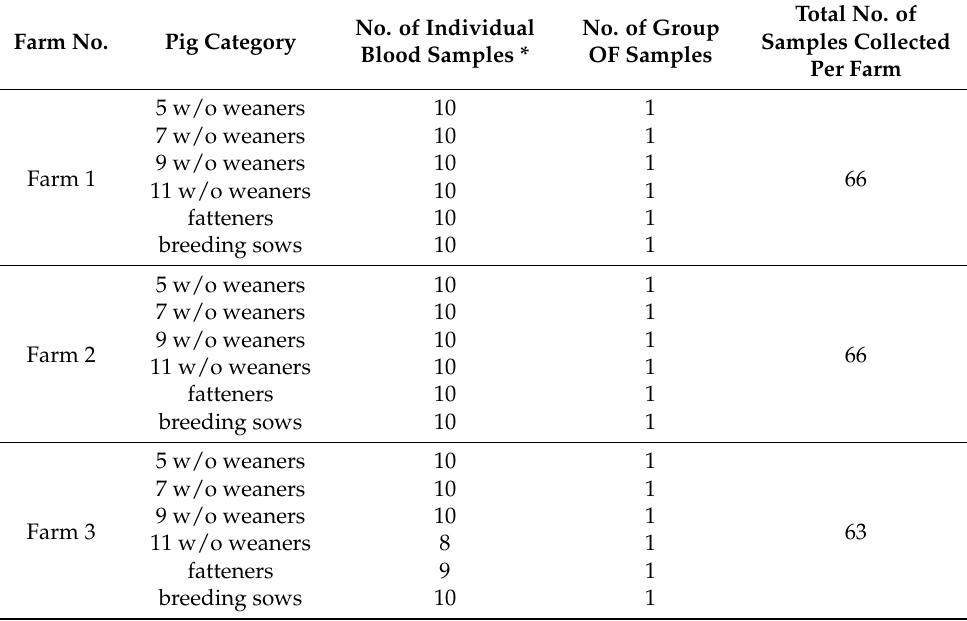
Total No. of No. of Group Samples Collected OF Samples Per Farm